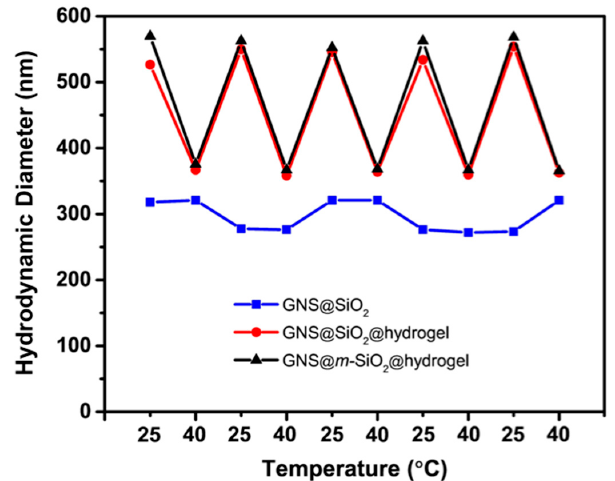
Figure 2. The hydrodynamic diameter of GNS@SiO 2 , GNS@SiO 2 @hydrogel, and GNS@m-SiO 2 @hydrogel, as a function of temperature. The data shown is of a representative set taken from five separate experiments.